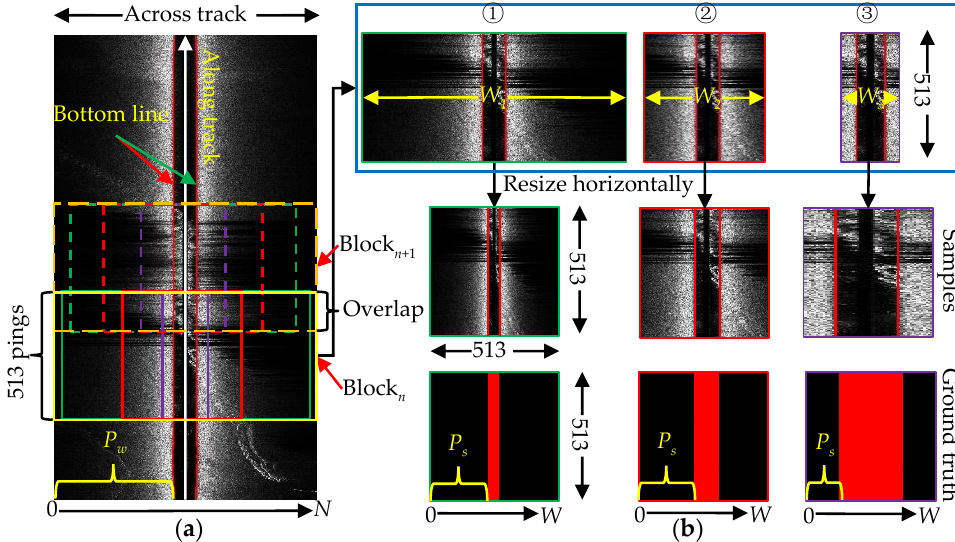
Figure 3. The process of collecting samples. ( a ) Waterfall image of a survey line. ( b ) Samples for training. ① ~ ③ are three sub image blocks with different width.